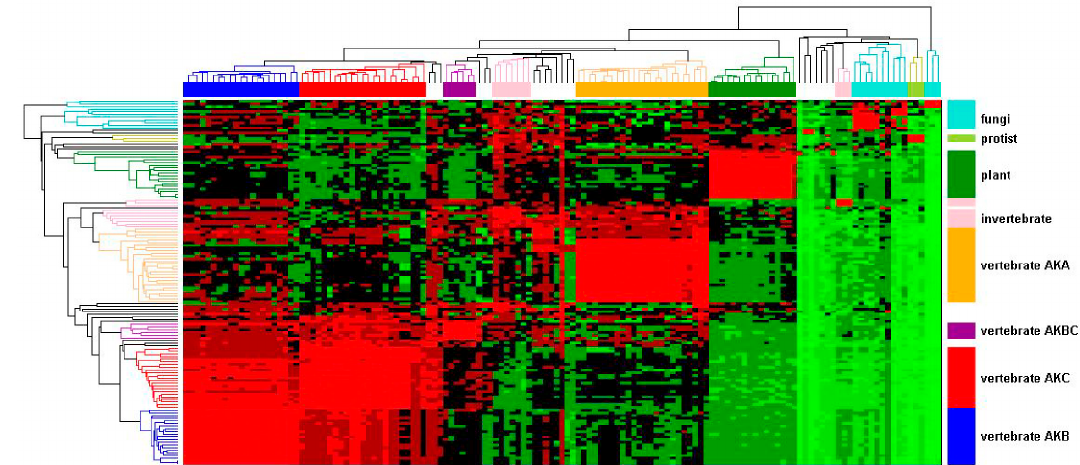
Figure 1. Evolutionary relationships in the AK gene family. An AK gene family hierarchical cluster was constructed based on percent identity. Each AK protein sequence was chosen in turn as query sequence in Blastp searches. The resultant pair-wise percent identities were plotted. The identity is indicated by color, ranging from the highest to lowest identity, progressively colored light red, red, maroon, black, dark green, medium green, and light green. The AK isoform designation refers to the vertebrate isoforms; other designations refers to the relevant species groups: invertebrates, protist, fungi, or plant.